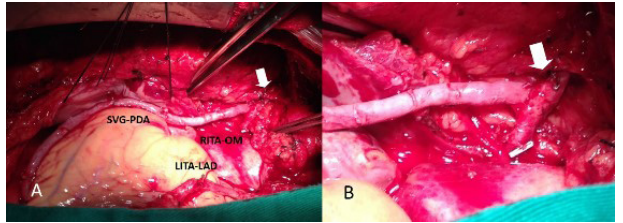
Fig. 4 - A. In situ right internal thoracic artery (RITA) grafted to obtuse marginal (OM) and routed through the transverse sinus. The saphenous vein graft (SVG) to posterior descending coronary artery (PDA) is proximally anastomosed end-to-side to RITA (white arrow). B. Detail of the SVG end-to-side anastomosis to RITA stump (white arrow). LAD=left anterior descending coronary artery; LITA=left internal thoracic artery.